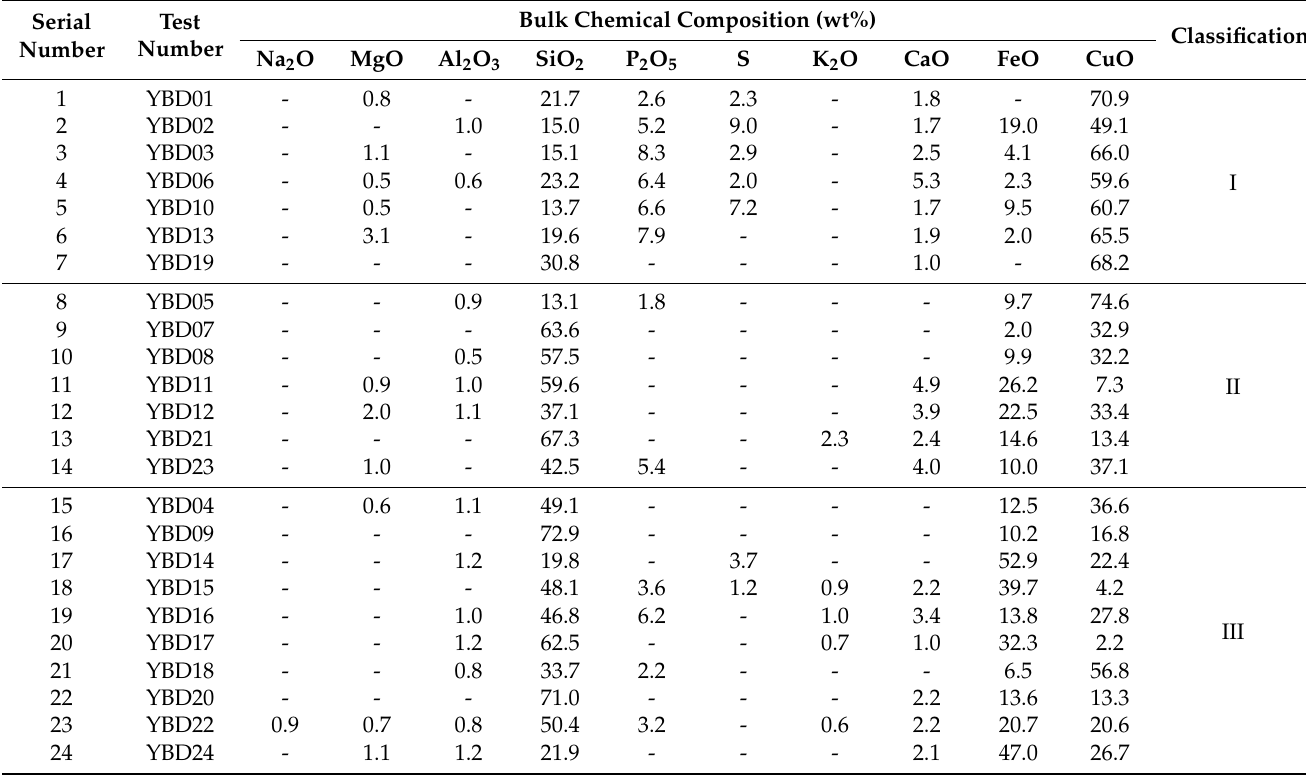
Table 1. Chemical composition of slag from Yubeidi